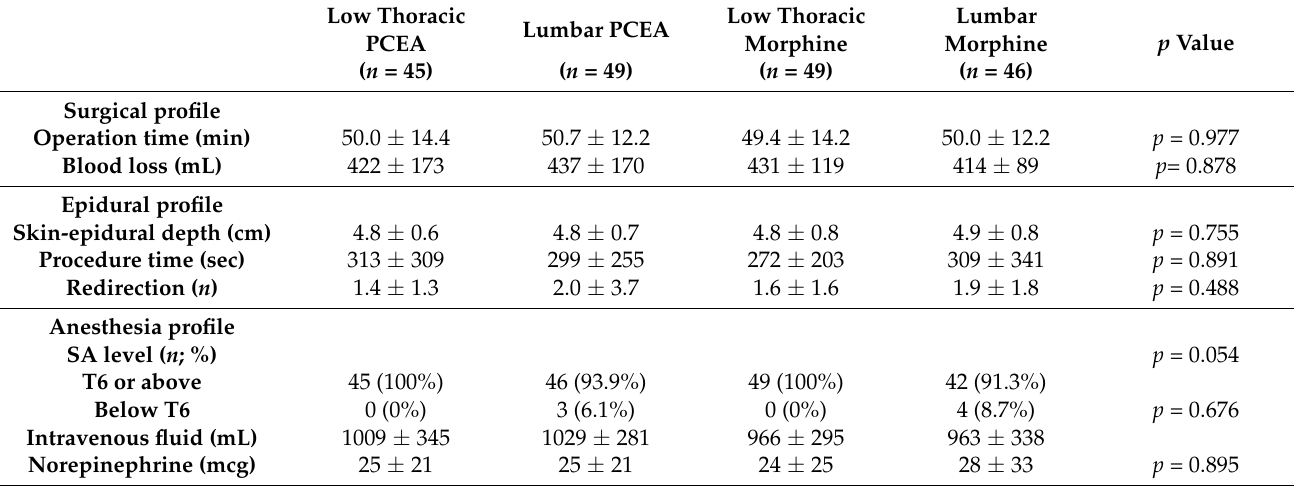
Table 2. Intraoperative